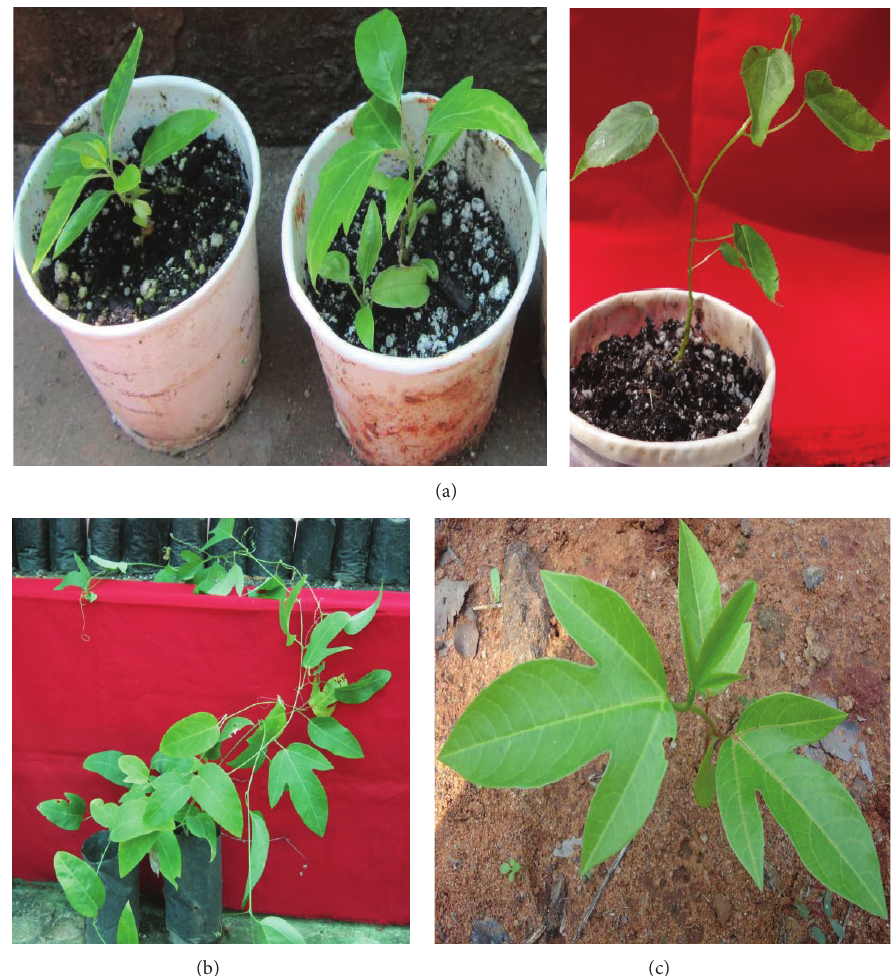
Figure 3: (a) Hardening of plantlets in the greenhouse. (b) Plantlets in nursery polybags. (c) Acclimatized plant of passion fruit growing in the natural